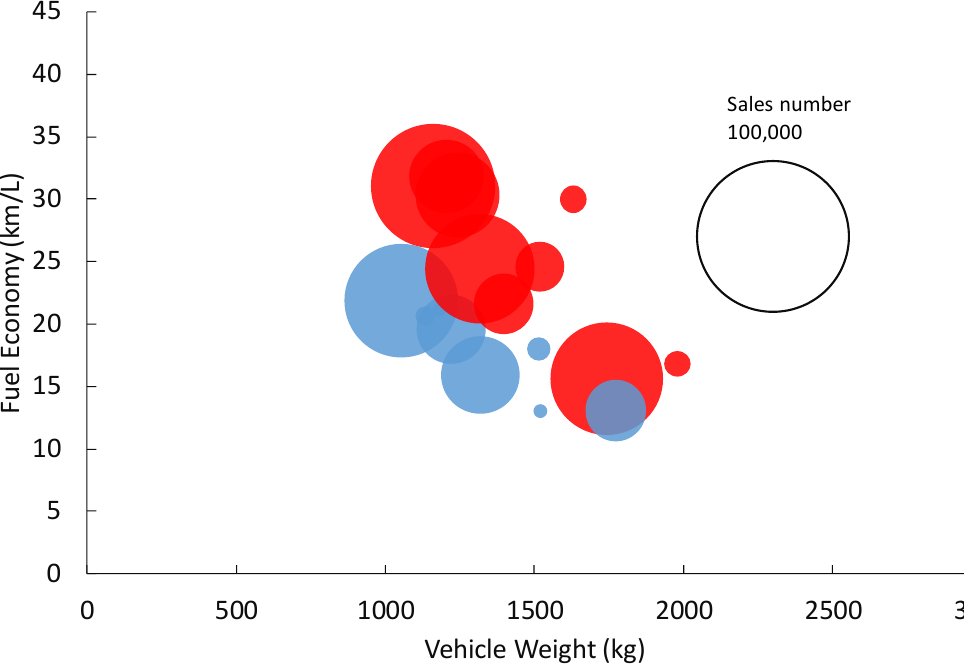
Figure A1. The relationships between fuel efficiency by vehicle model, vehicle weight, and the number of vehicle sales by model for Toyota.